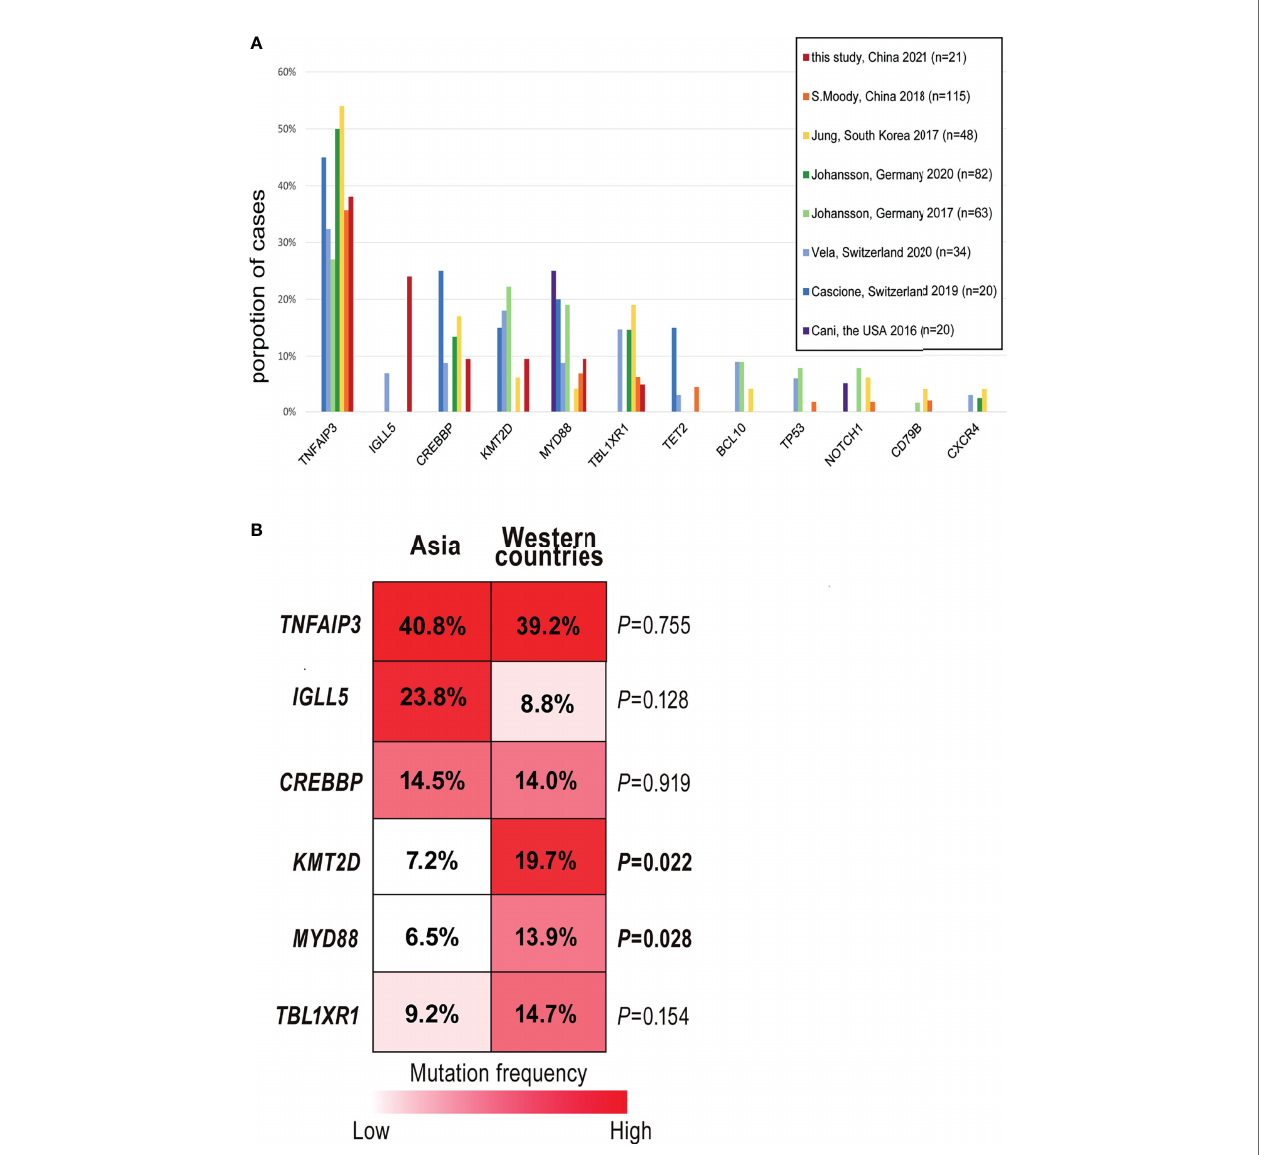
FIGURE 5 | Comparisons of the mutation frequencies from different studies. (A) Column graphs show the proportion of 11 common mutated genes reported by seven previous studies in ocular extranodal marginal zone lymphoma of mucosa-associated lymphoid tissue (OAML). Each column represents a gene ranked in decreasing order of average detection frequency in the tumor. (B) Stacked column plots display the comparisons of the fi ve most common genes detected in this study. Mutation rates were calculated by dividing the number of cases carried mutant gene by the study cohort ’ s size and total the number of cases with mutations from 8